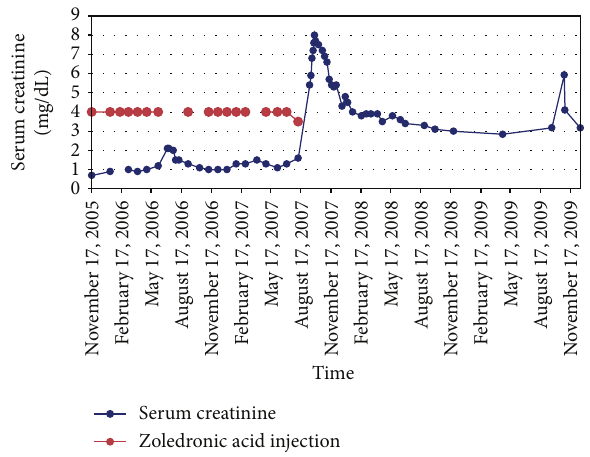
Figure 2: Evolution of serum creatinine in relation to injections of Zoledronic